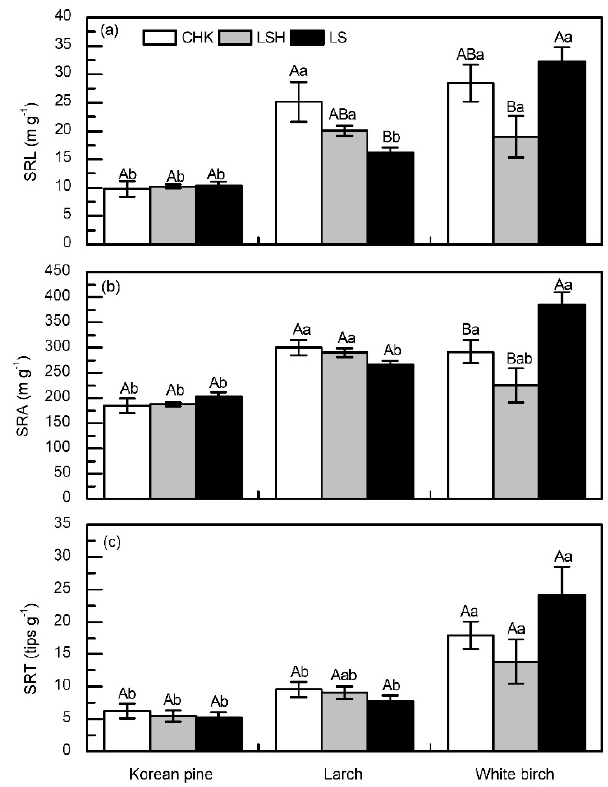
Figure 2. Root morphological traits of Korean pine, larch, and white birch at three sites in Northeast China. ( a ) specific root length (SRL), ( b ) specific root surface area (SRA), and ( c ) specific root tips (SRT). Vertical bars are means ± SE, with a sample size of n = 6. Different capital letters indicate significant differences ( p < 0.05) within a site. Different lowercase letters indicate significant differences ( p < 0.05) within a species.